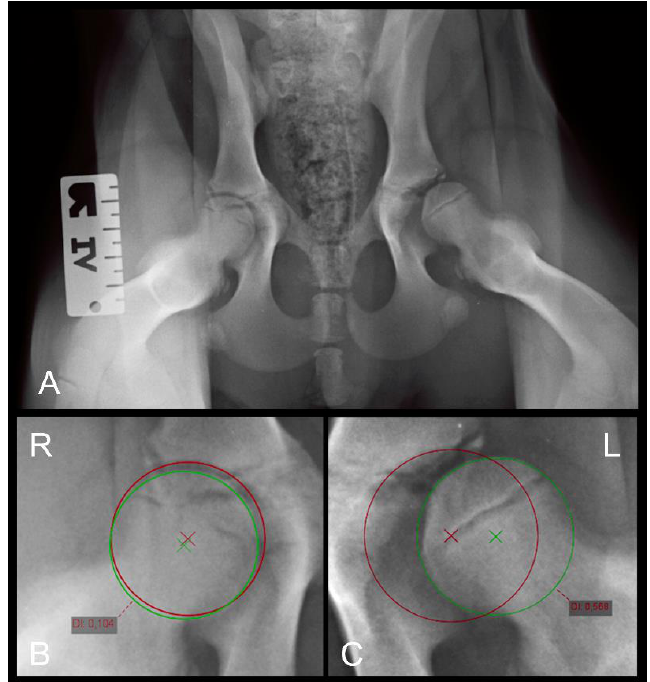
Figure 2. ( A ) Distraction view VD radiograph of a four-month-old Rottweiler (same dog as in Figure 1A,B). ( B ) A magnification of the right and ( C ) a magnification of the left hip joint demonstrating